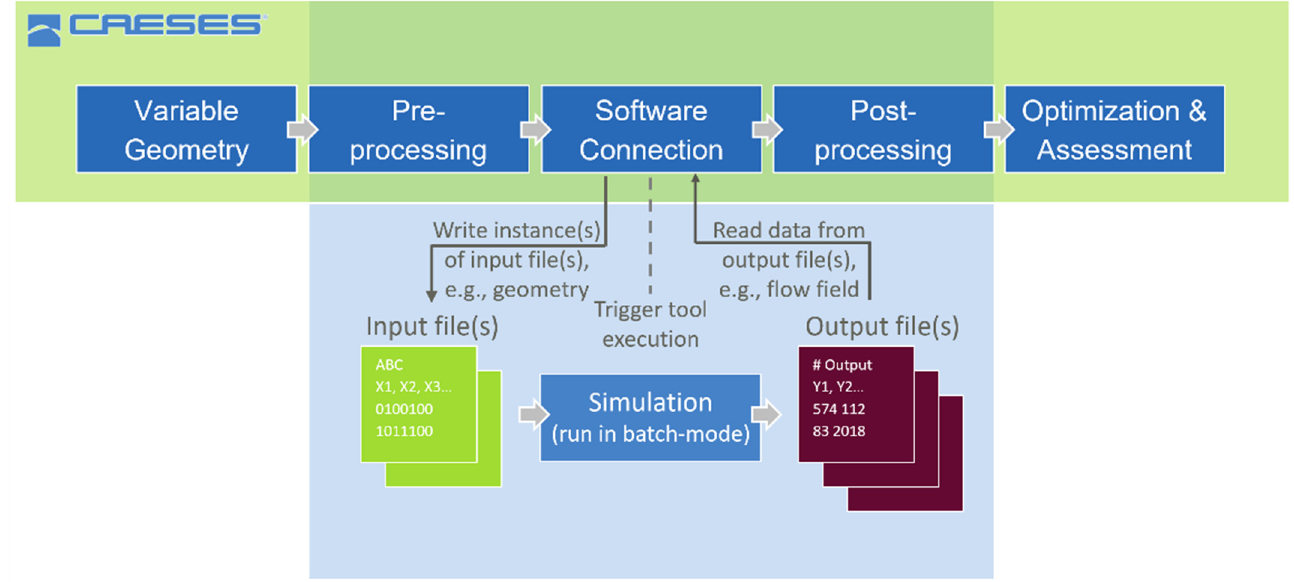
Figure 9. Overview of CAESES ® main functionalities with a selection of integrated software systems & providers from the HOLISHIP consortium.